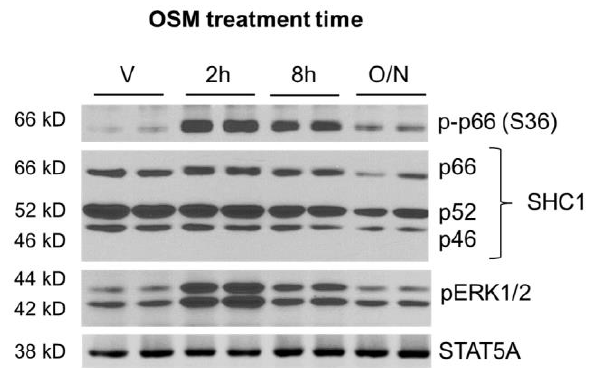
Figure 3. OSM induces phosphorylation of the p66 isoform of SHC1 at serine 36 (S36). 3T3-L1 adipocytes were exposed to 0.5 nM OSM at various times. Cells were harvested after OSM exposure and subjected to immunoblotting for phospho-p66 (S36), total SHC1, and phospho-ERK1/2; STAT5A was used as a loading control. OSM strongly stimulated p66Shc and ERK1/2 phosphorylation at 2 h and 8 h of treatment. The immunoblot depicted here represents results from two independent experiments, each with 3 wells per condition (n = 6 total wells per condition).